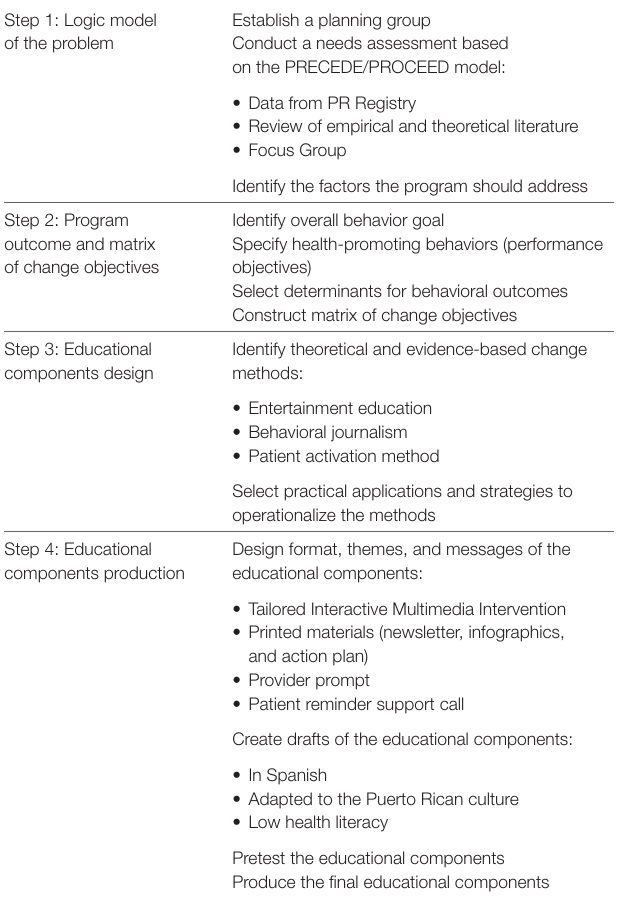
table 1 | Intervention mapping (IM) to develop health educational components to increase colorectal cancer screening in Puerto Rico (PR) (steps 1–4). Step 1: Logic model of the